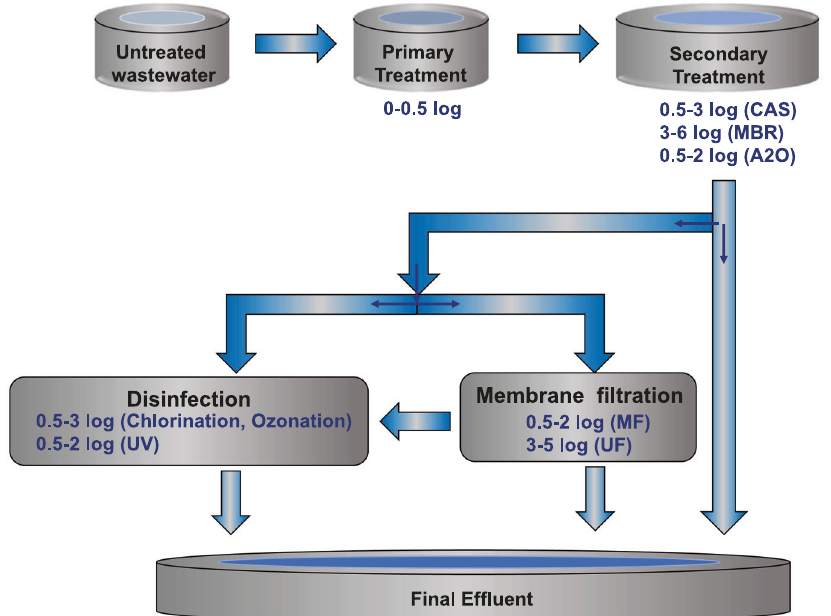
Fig. 2 Typical log removal values (LRVs) of viruses in the wastewater treatment process. CAS conventional activated sludge process, MBR membrane bioreactor process, A2O anaerobic – anoxic – oxic process, UV ultraviolet disinfection, MF micro fi ltration, UF ultra fi